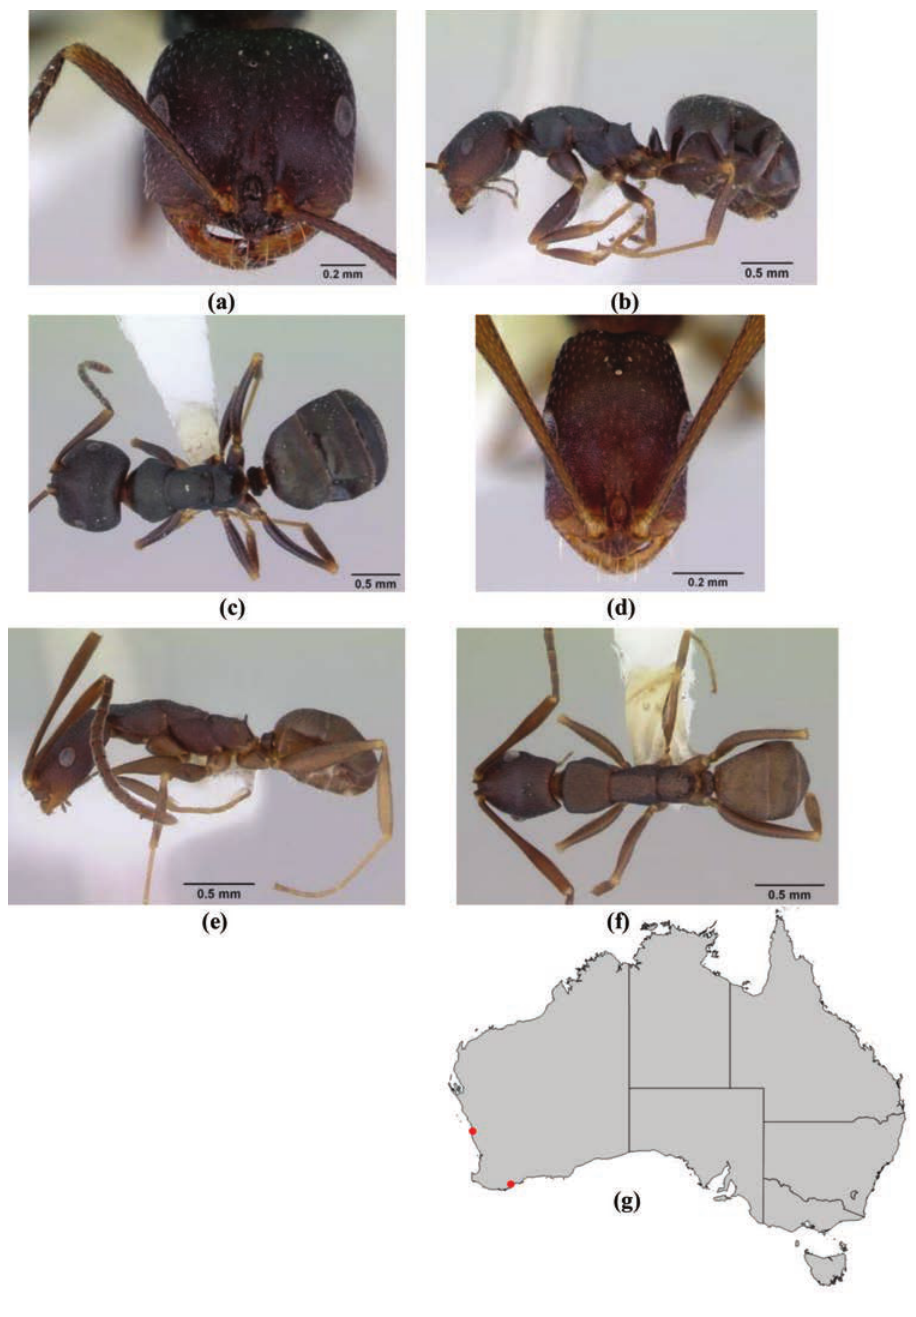
Figure 95. Melophorus majeri Agosti: ANIC major worker paratype (CAS0172019) frons ( a ), profile ( b ) and dorsum ( c ); ANIC minor worker holotype (CAS0172020–second ant on pin) frons ( d ), profile ( e ) and dorsum ( f ); distribution map for the species ( g